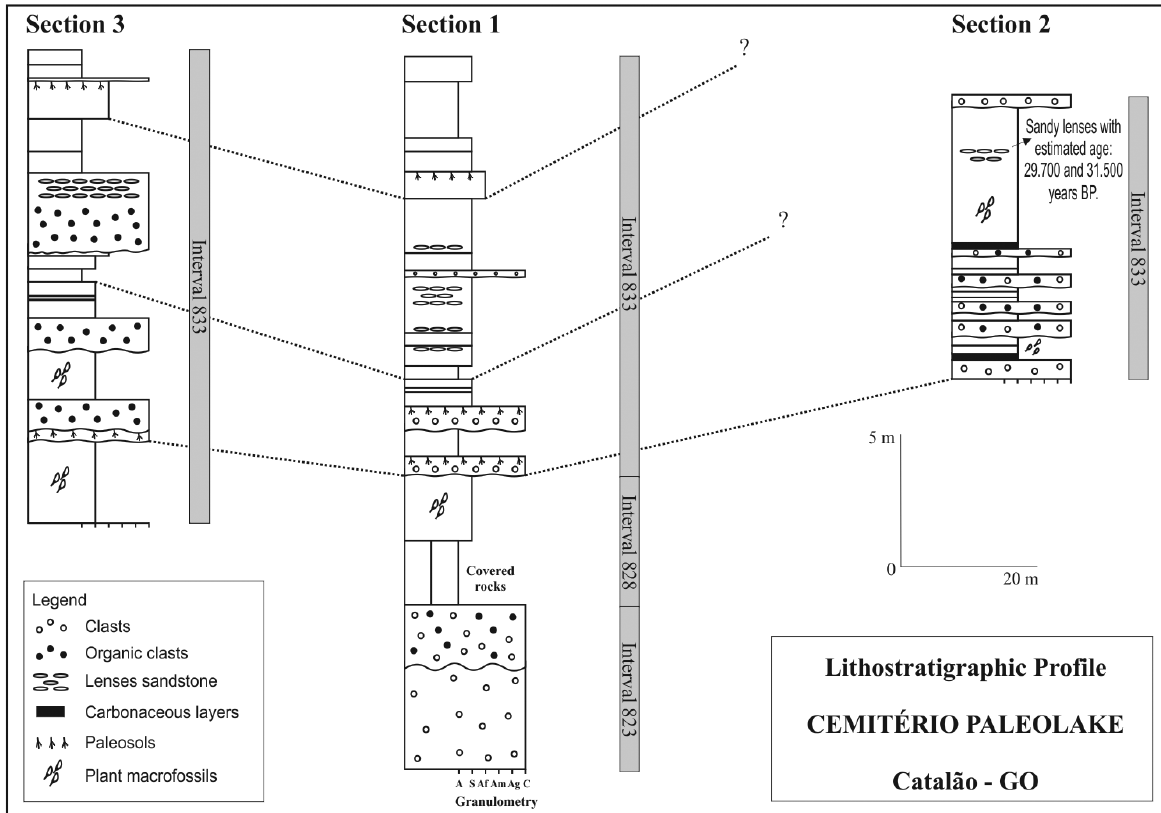
Fig. 3. Lithostratigraphic profile of the Cemitério Paleolake, Catalão, Goiás, showing the correlation among the three sections analyzed. From N.C., unpublished data. (A, argillite; S, siltstone; Af, fine sandstone; Am, medium sandstone; Ag, coarse sandstone; C, conglomerate).